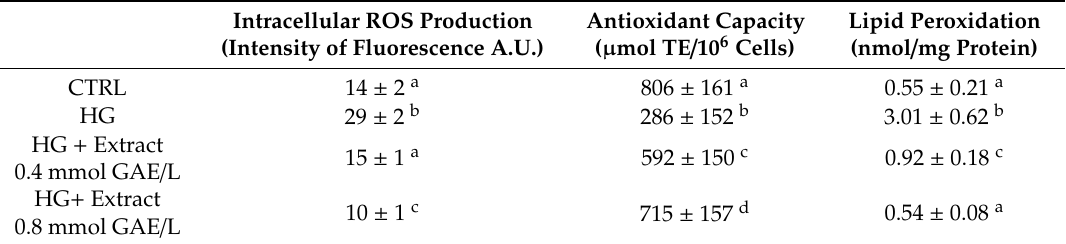
Table 2. The oxidative stress in HG-treated CaCo-2 cells with or without polyphenols extract. Intracellular ROS production, total antioxidant capacity, lipid peroxidation, and total AGEs levels in control cells (25 mM glucose, Ctrl) or high glucose treated cells (50 mM glucose) incubated in the absence (HG) or in the presence of apple polyphenolic extract (0.4 and 0.8 mmol GAE / L). Results are represented as mean ± SD of 5 determinations carried out in triplicate. Di ff erent letters a–d indicate significant statistic di ff erences between samples ( p <